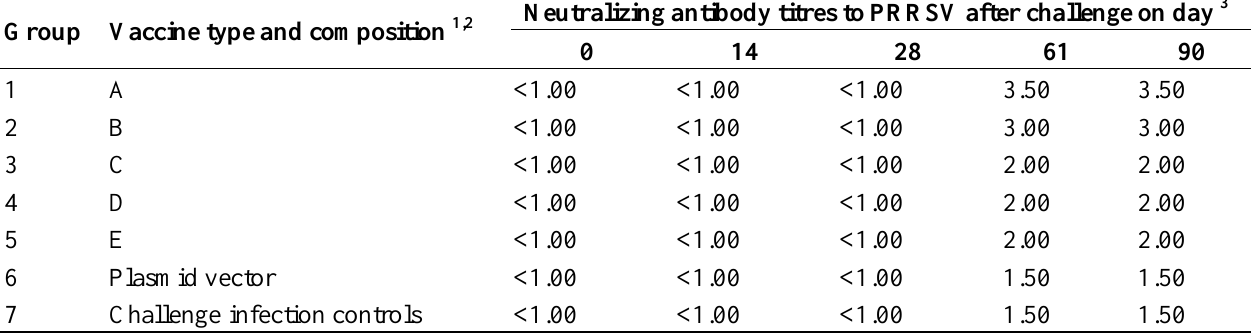
Table 4. Serum neutralizing antibody response of pigs immunised with experimental PRRS DNA vaccines and challenge infected with virulent